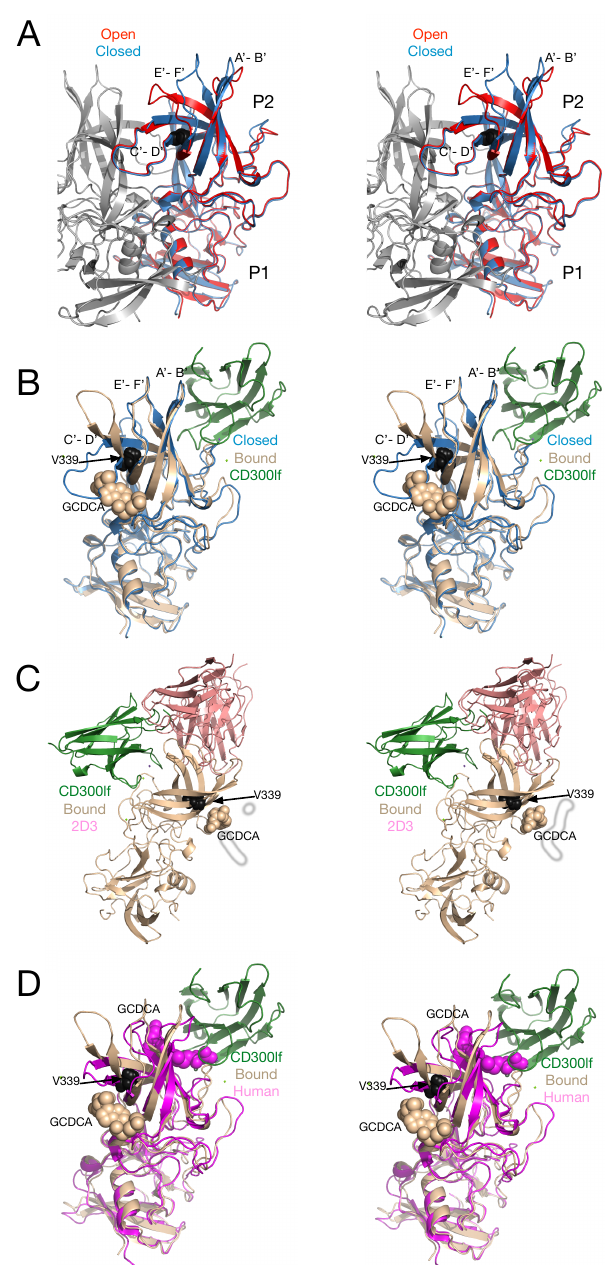
Figure 8. Comparisons of various P domain structures and complexes. Panel ( A ) shows an overlay of the open (red) and closed (blue) conformations observed in the MNV P domain crystal structure [19]. Panel ( B ) shows an overlay of the MNV P domain (tan ribbon) with receptor (green ribbon) and bile salts (tan spheres) onto the closed conformation (blue) from panel A. Also shown is the location of the V339I escape mutation to antibody 2D3 (black spheres). Note that the conformations of the A’-B’ and E’-F’ loops with the bound receptor is nearly identical to that of the closed conformation in panel ( A ). Also note that the V339I escape mutate is immediately adjacent to the bound bile salts. Panel ( C ) shows a hypothetical overlay of the P domain with 2D3 antibody (pink) and CD300lf receptor (green) bound. While their binding sites do not directly overlap, it is impossible for both to bind simultaneously. Panel ( D ) shows an overlay of the MNV receptor complex (tan) with the human P domain complexed with bile salts (mauve). Note that CD300lf in MNV directly overlaps the bound GCDCA in the human norovirus